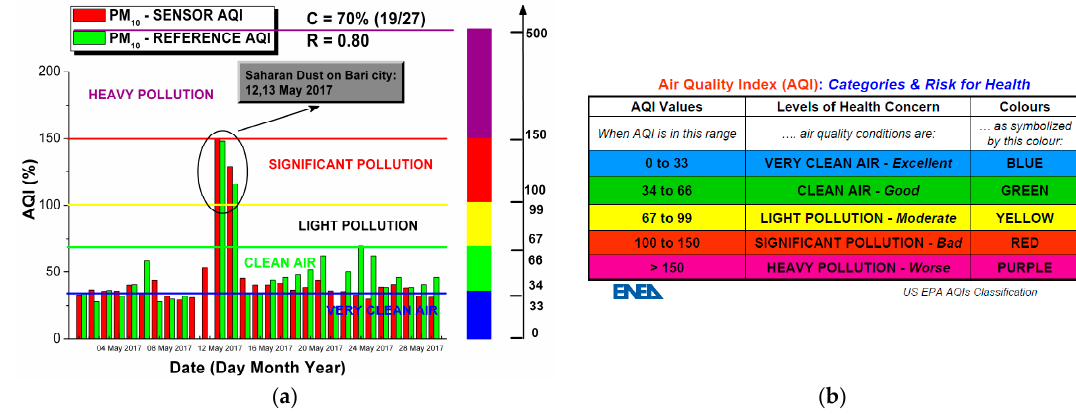
Figure 4. ( a ) PM 10 AQI measured by AIRBOX sensor (PPD20V, Shinyei) in the Node 6 (Airport) versus analyzer (ARPA-Puglia—EN2 Modugno) in Bari on May 2017; ( b ) Classification US EPA for AQI standard to assign risk categories to human health due to personal exposure to air pollution.